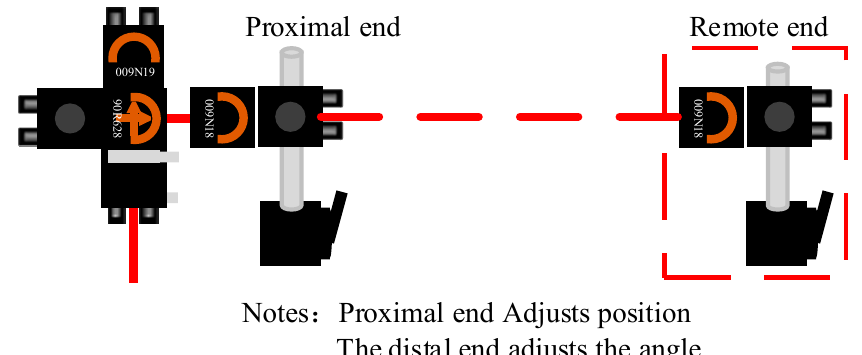
Figure 19. Combined laser interferometer X-axis measurement methods.